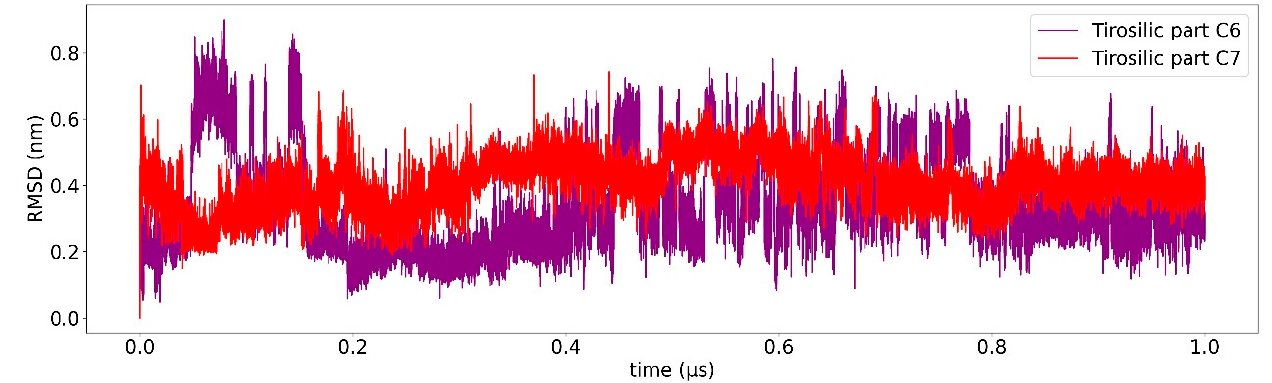
Figure 6. Root mean square deviation (RMSD) relative to 1 us of simulation. The RMSD of the tyrosolic part of compound c6 is shown in purple, the tyrosolic part of compound c7 is shown in red. High RMSF values indicate high flexibility of residuals during simulation.